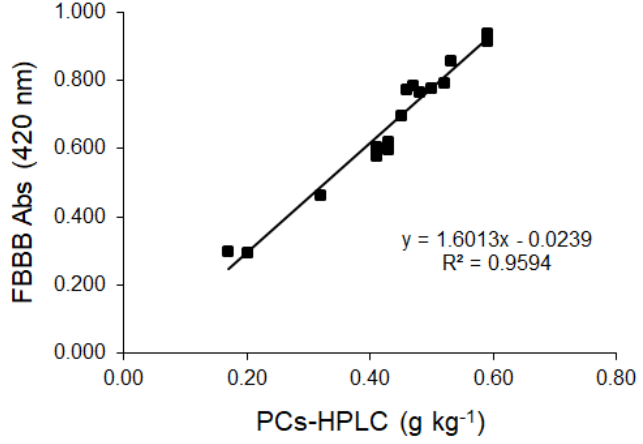
Figure 3. Pairwise correlation between Fast Blue BB (FBBB) absorbance and total biophenols deter- mined with the HPLC-UV method (PCs-HPLC) for the 16 EVOO samples analyzed. Values are means of three replicates. Relative standard deviation (% RDS) was <5% in all cases and error bars have been omitted.